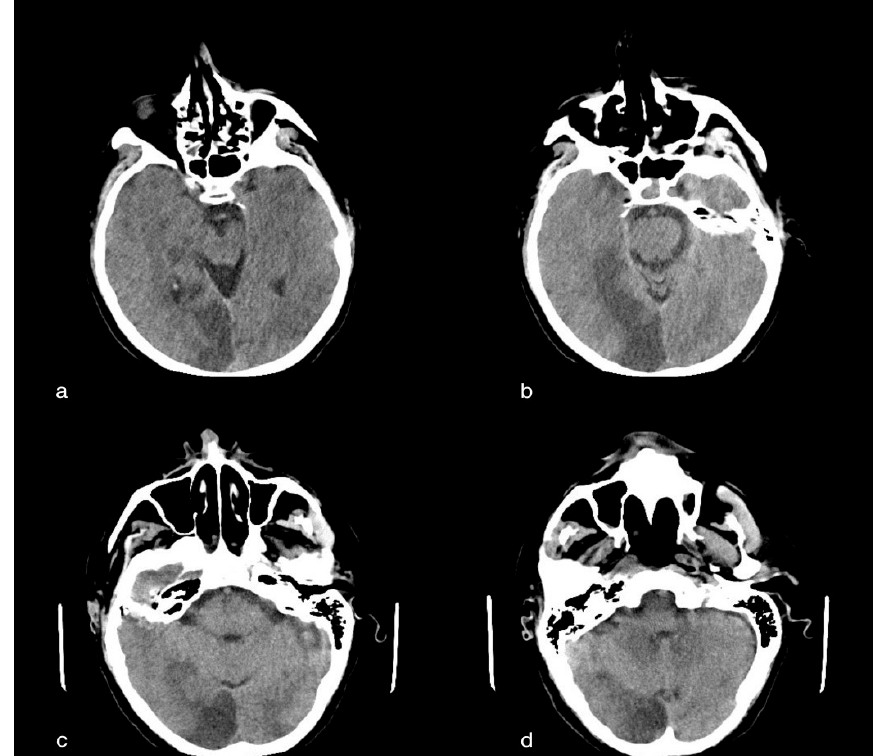
Figure 2. A 60-year-old male patient with acute ischemic vascular pathology in the left temporo- parietal region, cortico-subcortical in origin, extending to the ipsilateral deep white matter, charac- terized by a slight parenchymal hypodensity, and responsible for the modest compression of the ipsilateral ventricular, subarachnoid and parenchymal compartment, but without deviation of the septum pellucid or third ventricle to the right of the line, subarachnoid and parenchymal compart- ments, but in the absence of deviation of the septum pellucid or third ventricle to the right of the median line or signs of intracranial hypertension.